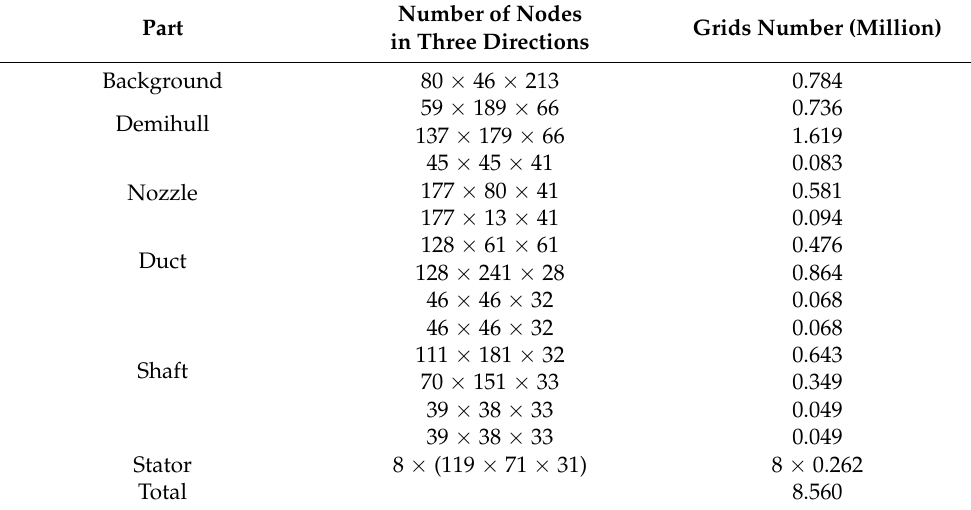
Table 5. Node distribution and grids number of the self-propulsion